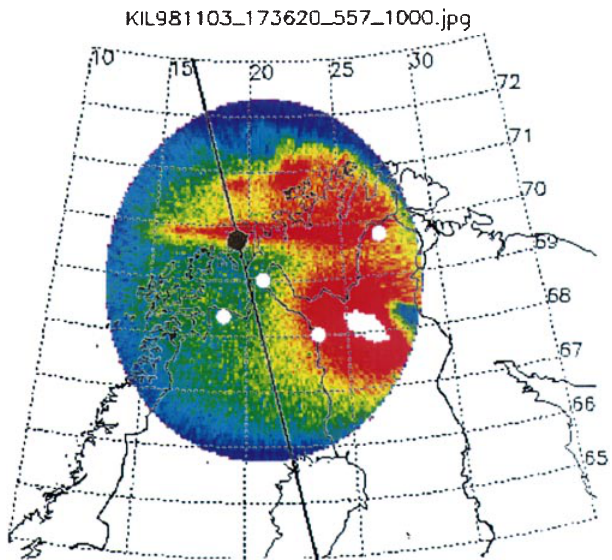
Fig. 4. Histogram-equalized false color image, mapped to 110 km altitude of the Kilpisja¨ rvi ( KIL ) all-sky camera (the white dot at the center of the circle) together with FAST trajectory and position ( black dot ) at 17:36:20 UT on November 3, 1998. We see that arc 2 is centered at about 70 (cid:14) geographic latitude and its width, as deduced from the all-sky camera is 30 km or smaller. The bright area dominating the southeastern part of the all-sky image is